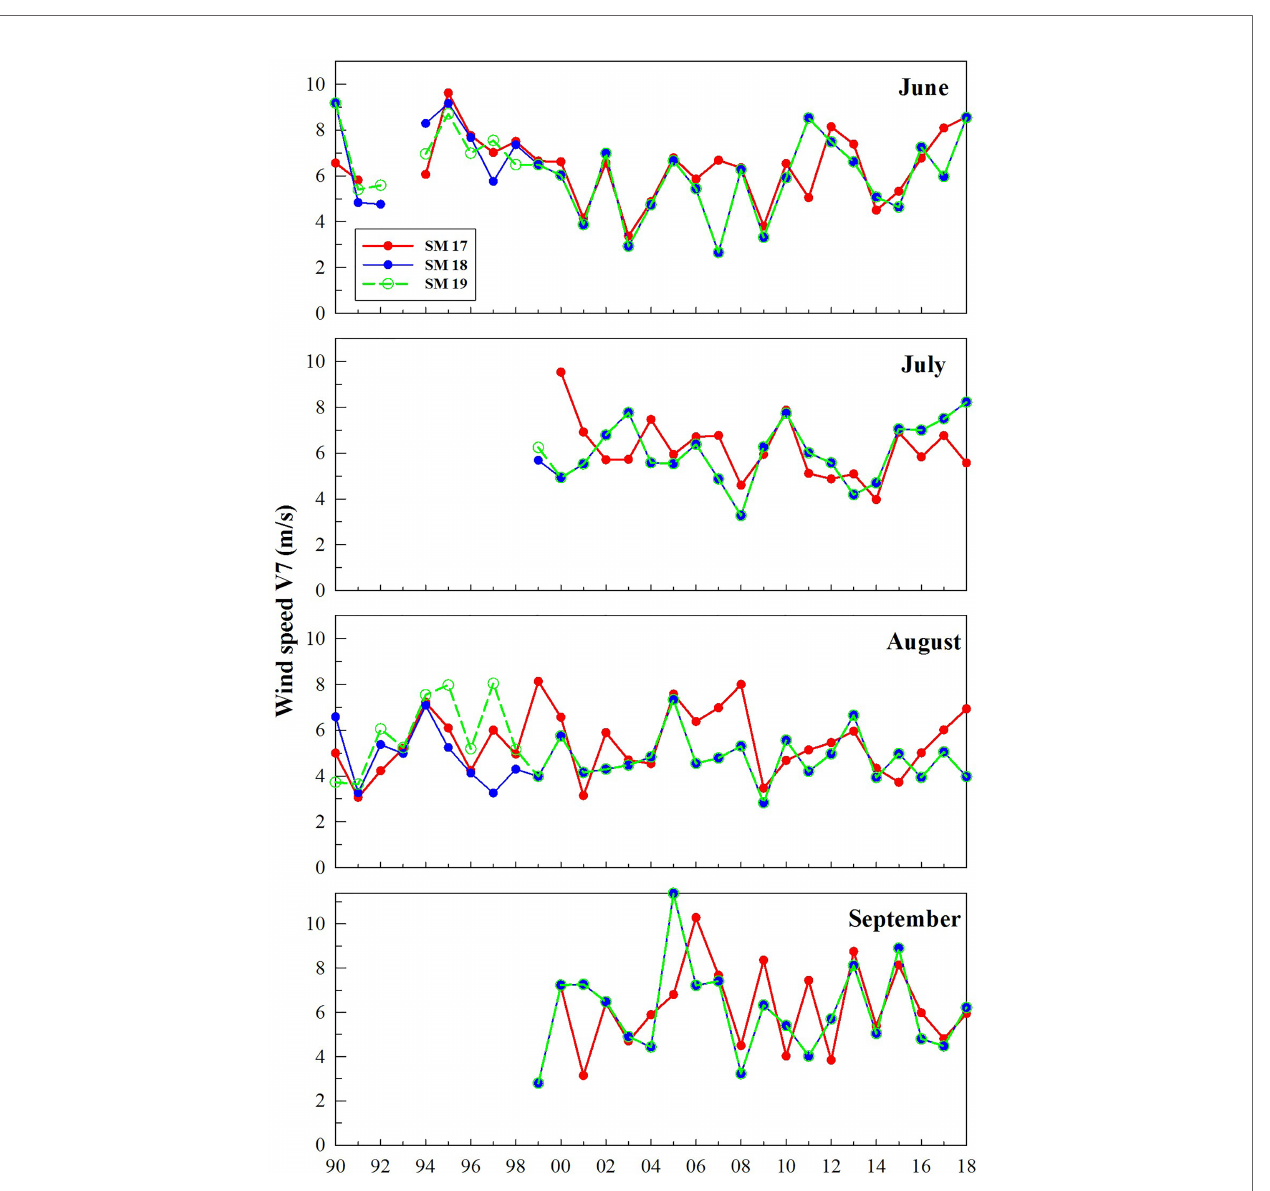
FIGURE 5 | Time series of averaged wind speed 7 days before sampling (V7) during 1990-2018 in summer at SM17, SM18 and SM19. There is no signi fi cant trend by linear